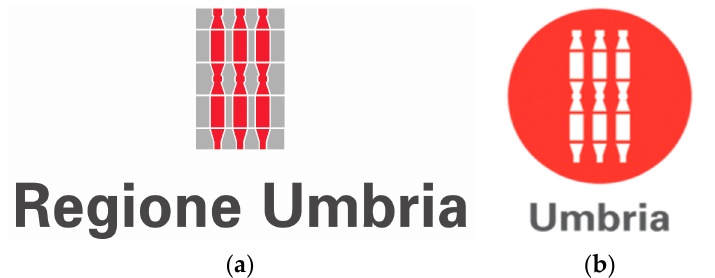
Figure 1. ( a ) Alberto Anselmi, Gino Anselmi, coat of arms of Italian region Umbria, 1973; ( b ) Studio Bcpt Associati, Red Seal ,